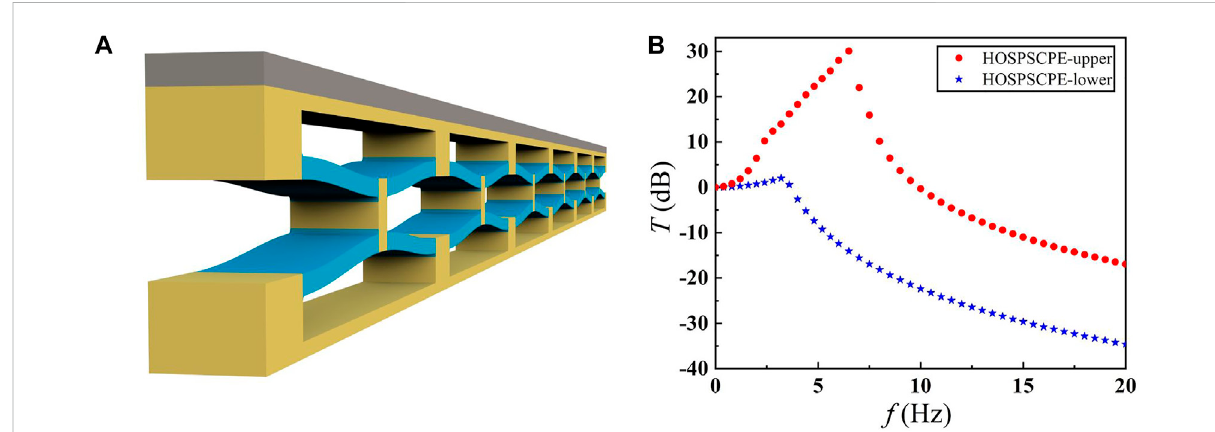
FIGURE 7 Dynamic uncertainty analysis of the QZS metastructure for vibration isolation. (A) The QZS metastructure model. (B) The transmittance of the QZS metastructure when the geometric uncertainty effect is